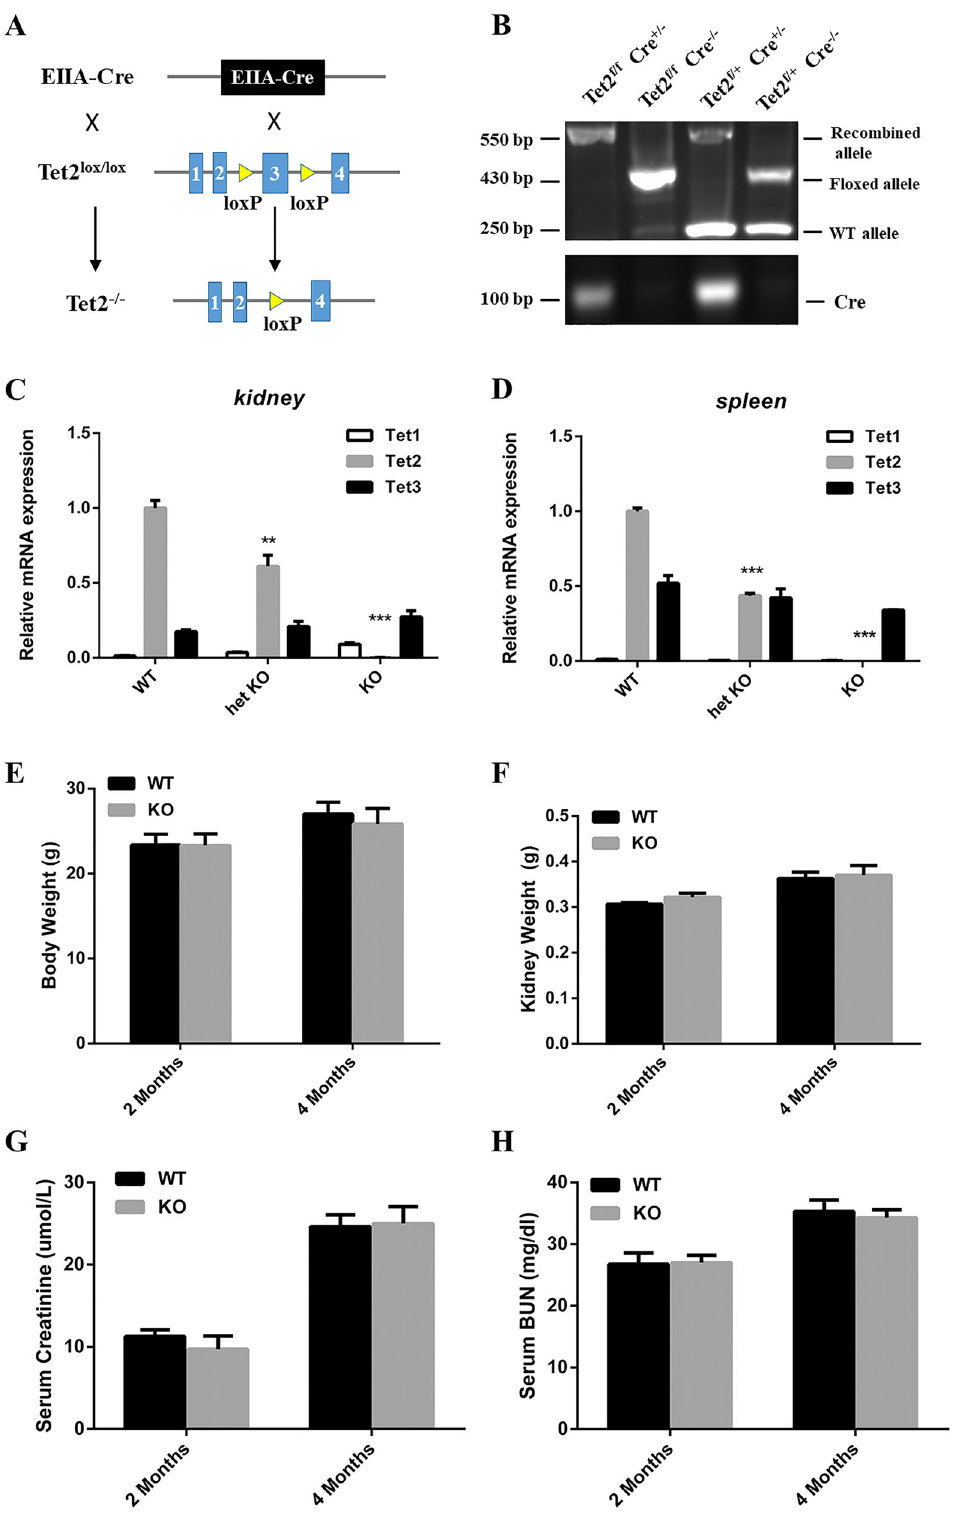
Fig. 2 Characterization of Tet2 -KO mice. A The schematic diagram showing the crossbreeding strategy of Tet2 - fl oxed mice ( Tet2 f/f ) with EIIa- Cre transgenic mice. B Mice genotyping by PCR analyses of genomic DNA. Lane 1: Tet2 f/f , Cre + / − , designated as KO, Lane 2: Tet2 f/f , Cre − / − , designated as WT. C Real-time PCR analyses demonstrated a substantial reduction of the spleen and renal Tet2 mRNA in KO mice compared to WT mice. *** P < 0.001 versus WT mice. E – H Tet2 gene deletion had no impact on phenotype. There was no signi fi cant difference in the body weight ( E ), kidney weight ( F ), Scr ( G ), BUN ( H ) between KO and WT mice at 2 and 4 months ( n = 6).